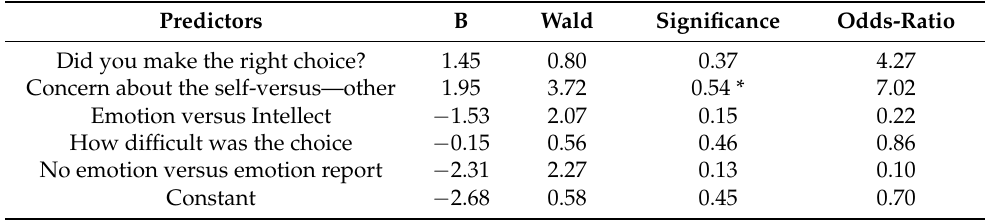
Table 2. Predictors in the logistic regression model with independent variable of condition (moral decision versus moral action). Predictors B Wald Significance Odds-Ratio Did you make the right choice?